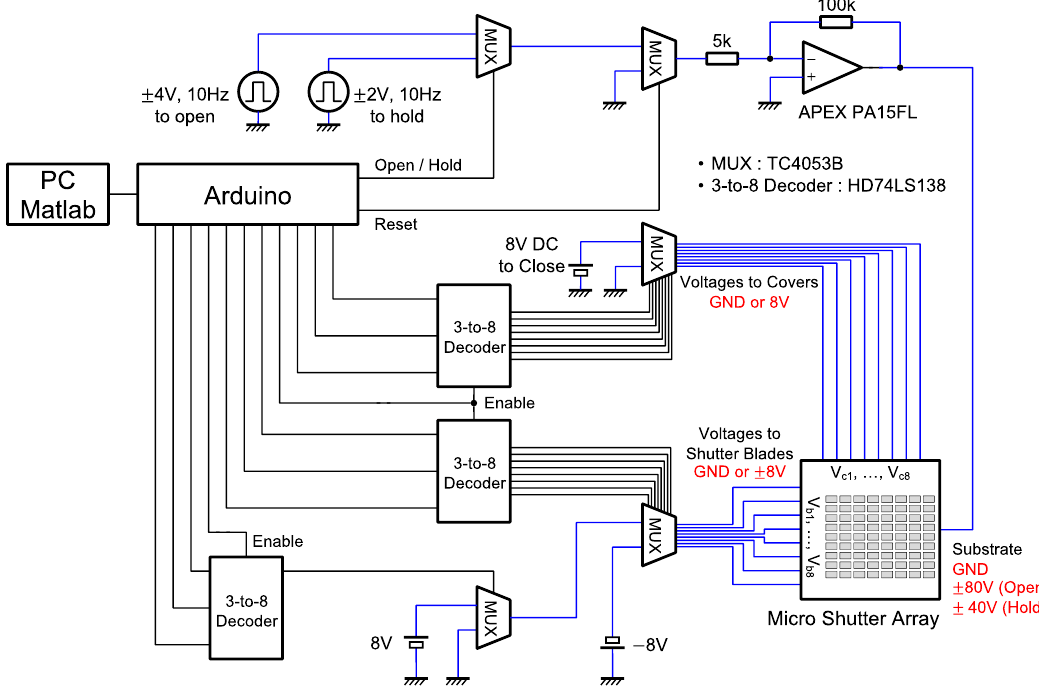
Figure 10. Block diagram of electrical circuit for addressing shutter elements. The digital output from the Arduino are used to control the pairs of decode and multiplexer (MUX) that deliver analog drive voltages to the rows and columns of the MEMS micro shutter array to individually close the shutter blades. High-voltage operation is applied to the common substrate that attracts the shutter blades to the open position.